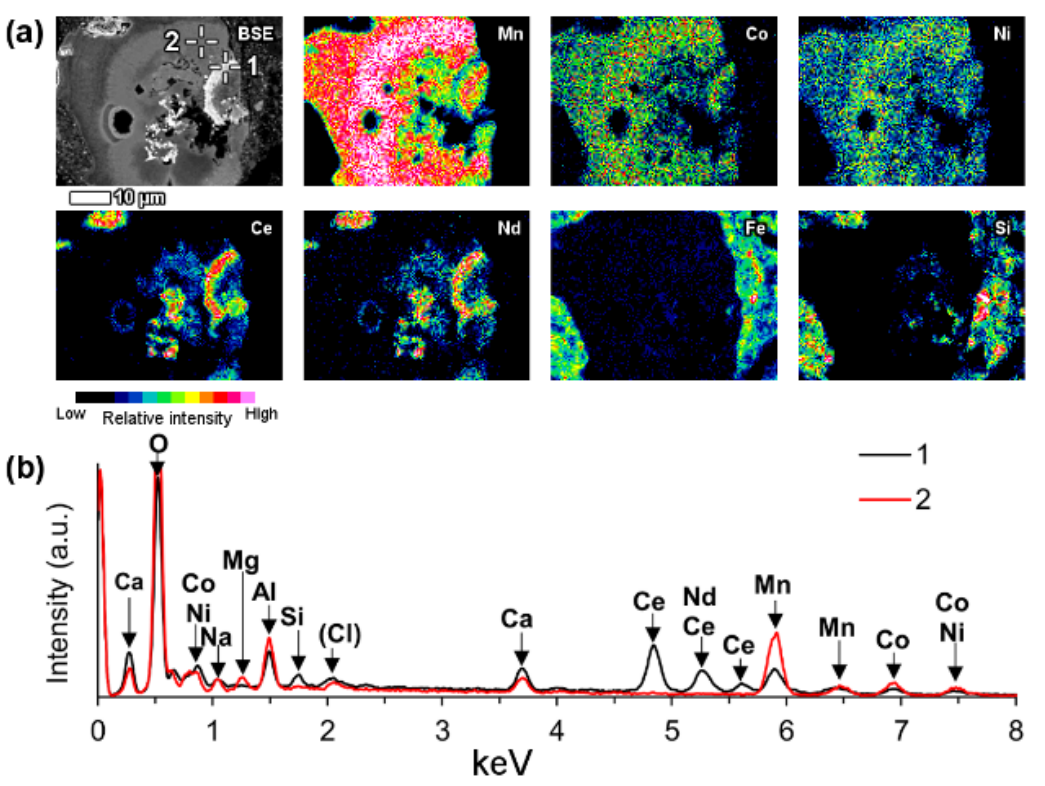
Figure 13. Cerium oxide/oxyhydroxide phase associated with manganese particle shown on ( a ) EDS elemental map with ( b ) respective spectra.